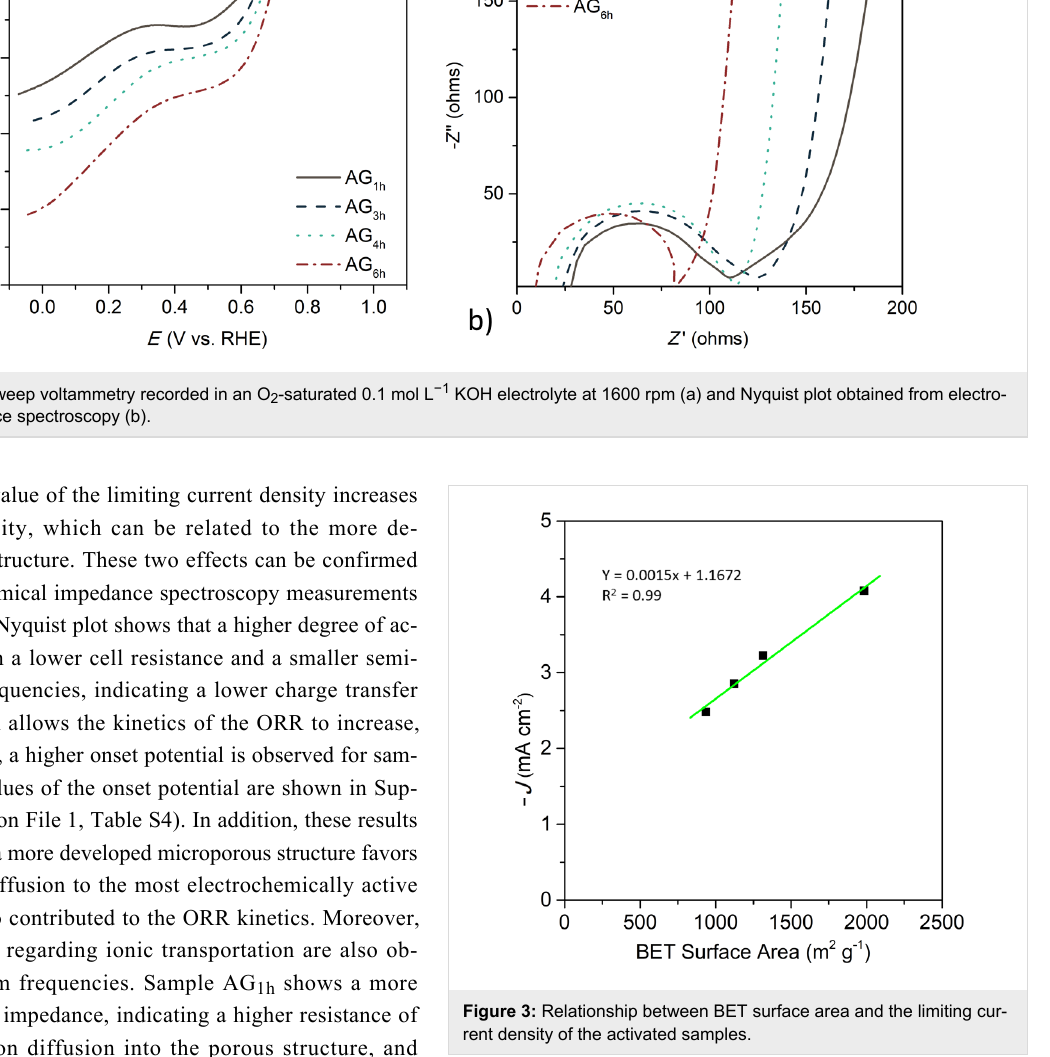
More than 18% of hydrogen peroxide was produced with AG 6h (Supporting Information File 1, Figure S2), which is not